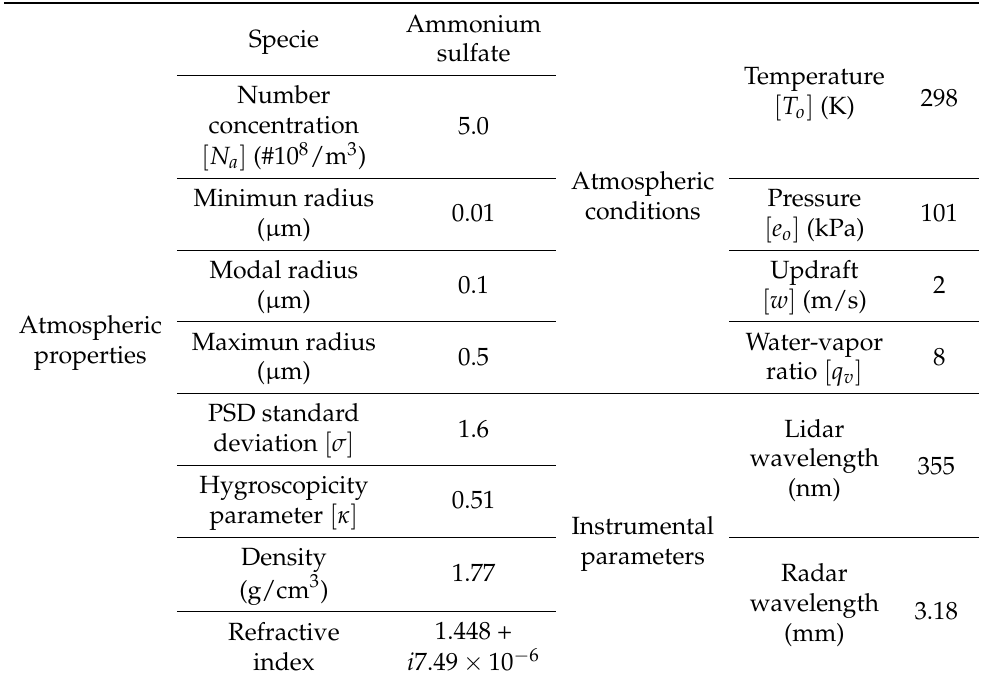
Table 1. Initial parameters used for ammonium sulfate ([32–35]).